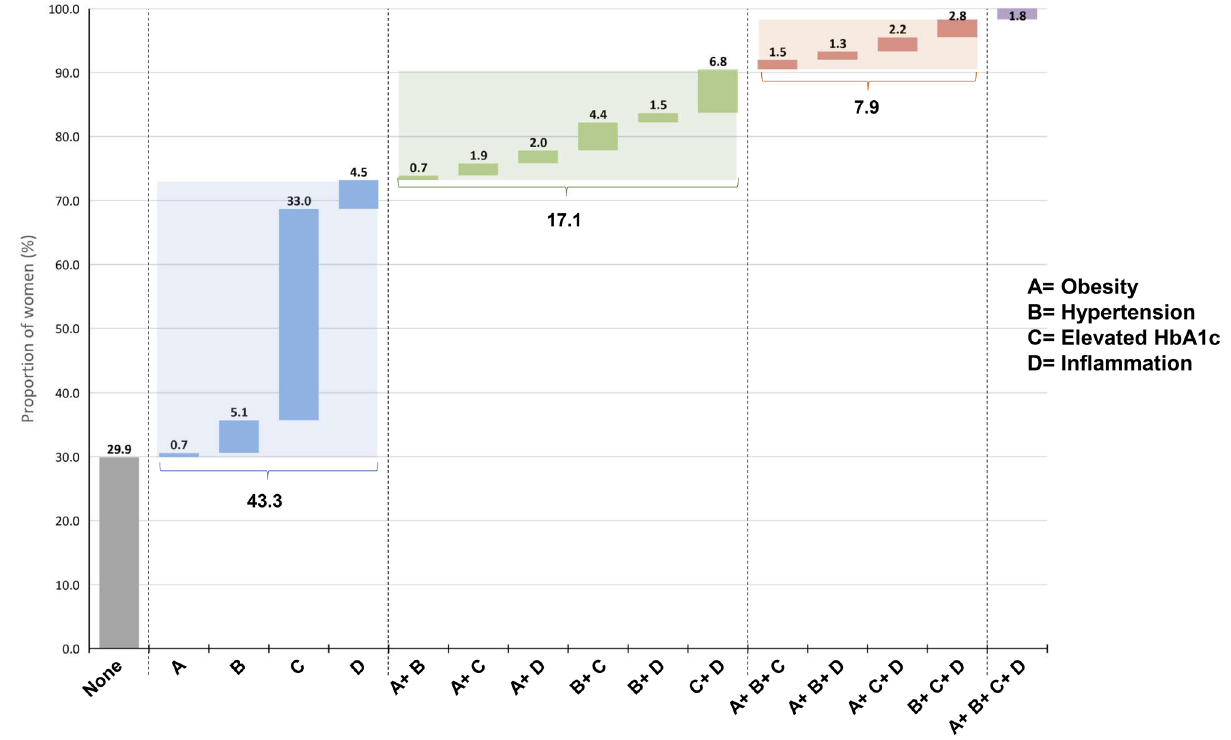
Figure 1. Coexistence of obesity (BMI ≥ 30.0), hypertension (systolic ≥ 140 mmHg or diastolic ≥ 90 mmHg), elevated HbA1c (≥ 5.7%) and inflammation (CRP > 3 mg/L and/ or AGP > 1 g/L) in the same woman (includes only the 1391 women with data on all cardio metabolic risk factors); grey = proportion of women without risk factor, blue = proportion of women with one risk factor, green = proportion of women with two risk factors, orange = proportion of women with three risk factors, purple = proportion of women with four risk